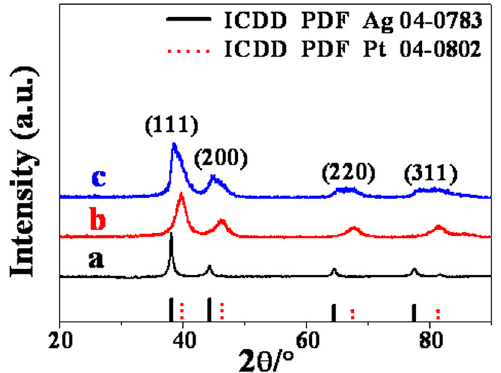
Figure 1. XRD patterns of Ag/GNs (a), Pt/GNs (b) and Pt ‐ Ag/GNs (c).